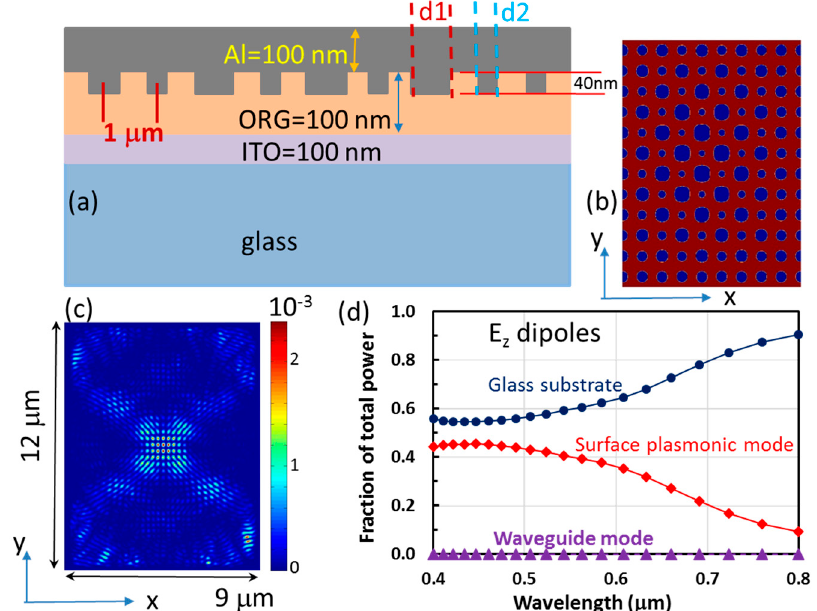
Figure 4. ( a ) Schematic of the organic light emitting device (OLED) where the cathode (Al) is patterned with the graded photonic super-crystal that has a rectangular unit super-cell; ( b ) output of the structure design from the simulation software MIT Electromagnetic Equation Propagation (MEEP); ( c ) electric-field intensity in the glass substrate in OLED at the location 740 nm away from indium tin oxide (ITO) layer; ( d ) the fraction of the total emitted power in glass substrate, both in the surface plasmonic mode and in the waveguide.